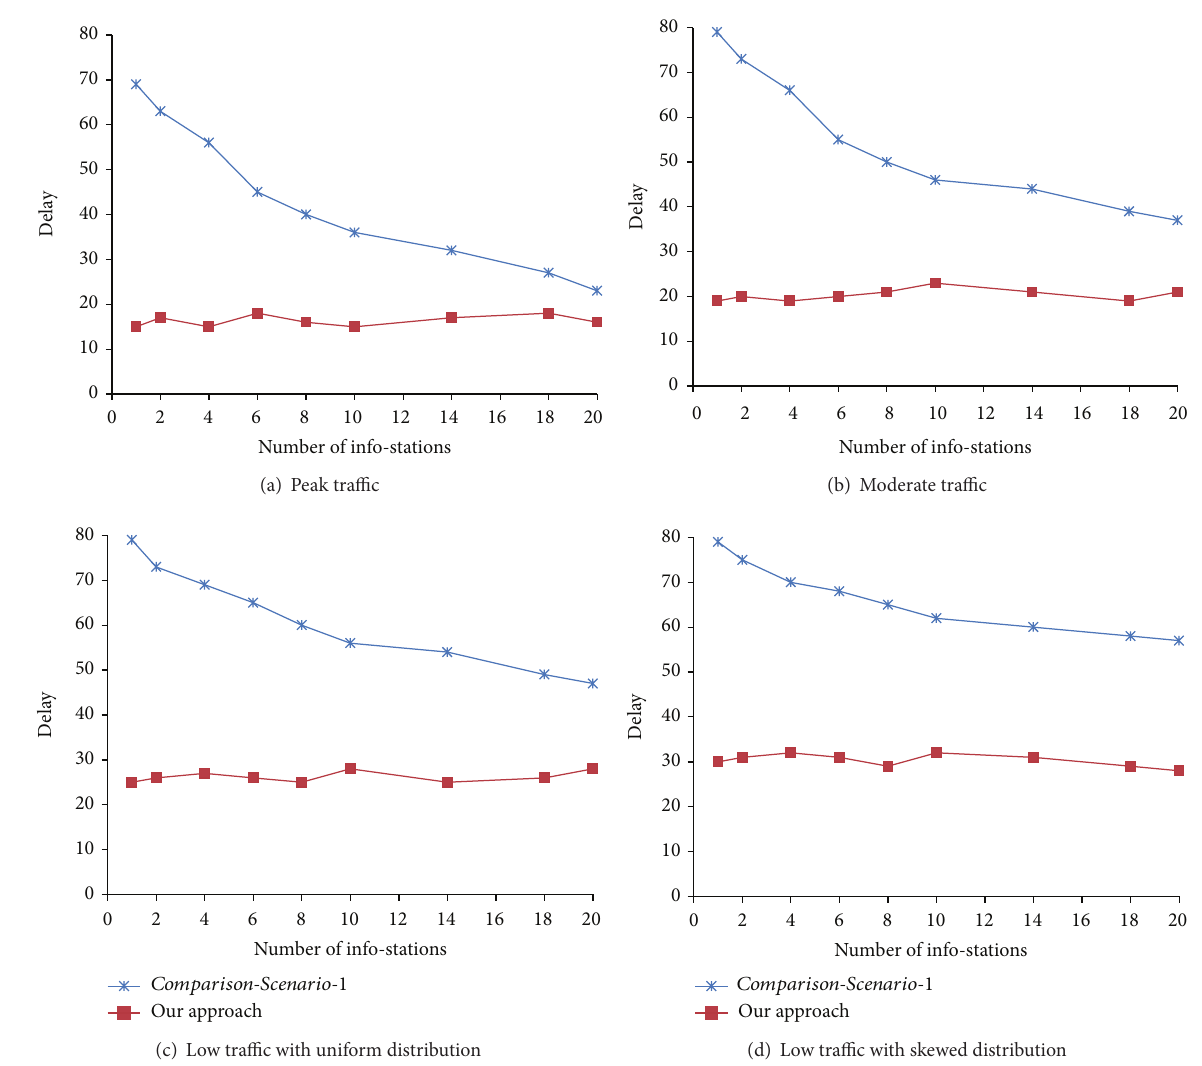
Figure 3: Notification delay: our approach versus Comparison-Scenario-1